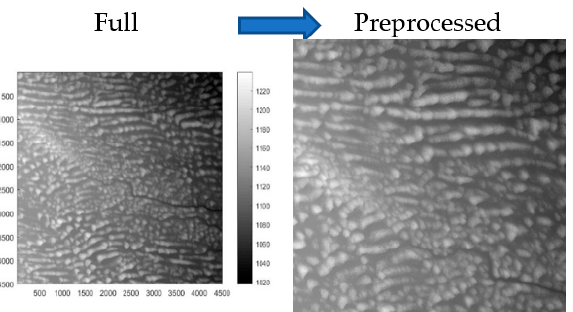
Figure 6. Stabilized sand dunes (Sandhills, NE, USA) [64]: 1000 × 1000 with pixel size of 30 m. Table 1. The detailed information of six study areas and experimental datasets (500 × 500).